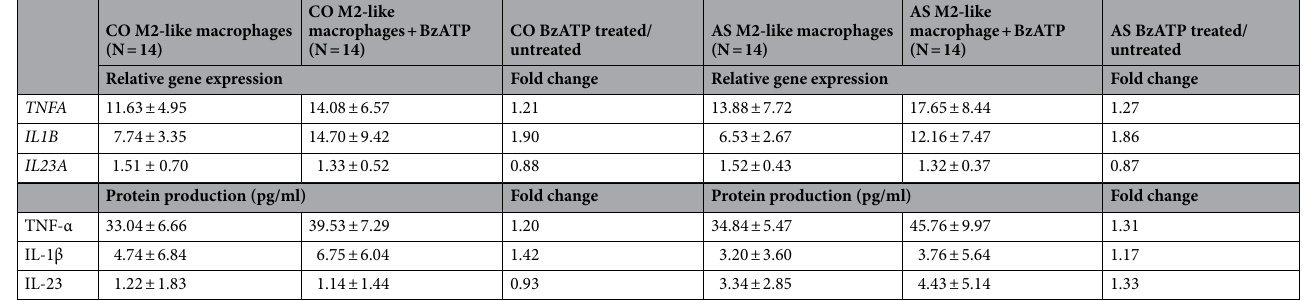
Table 2. The mRNA expression and protein production of IL-23, IL-1β, and TNF-α pro-inflammatory cytokines in monocyte-derived (M2-like) macrophages from AS patients and healthy controls before and after